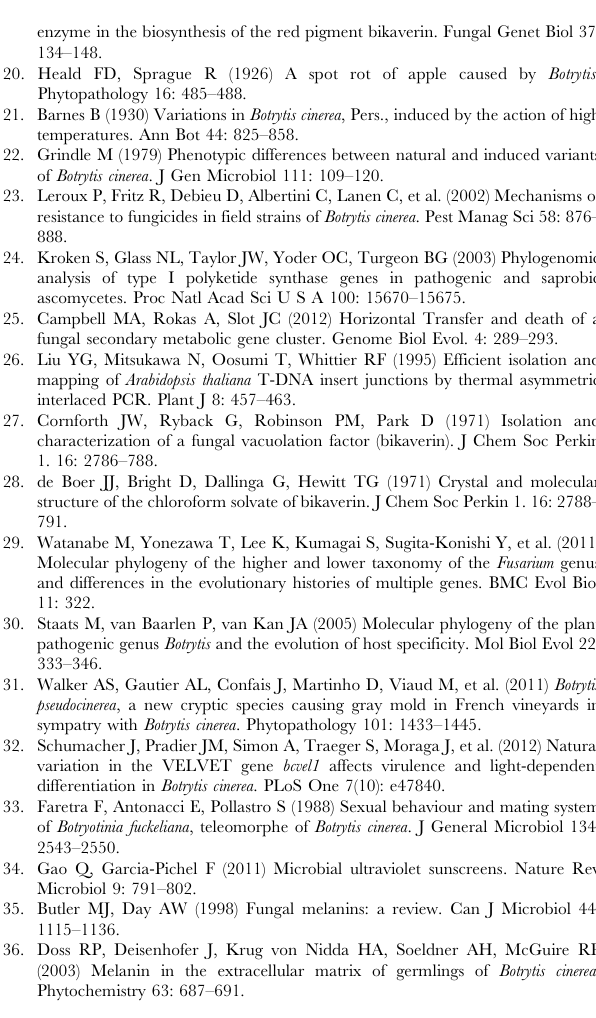
Figure S2 Alignment of bcvel1 sequences from the pink strains 1750 and 1787 and the gray strains B05.10 and T4. Nucleotide sequences were aligned using Lasergene’s MegAlign (DNASTAR). SNPs that resulted in stop mutations (T4 and 1750) are indicated in blue, in silent mutations in green (1750 and 1787) and SNPs that lead to an amino acid exchange (1787) are indicated in red. GenBank accession numbers are: bcvel1 B05.10 (GenBank: Table S1 Oligonucleotidic primers used for diagnostic PCR, sequencing, Tail-PCR and cloning. Table S2 Screening for the presence of BcBIK1 and BcBIK6 genes in different Botrytis strains using PCR.